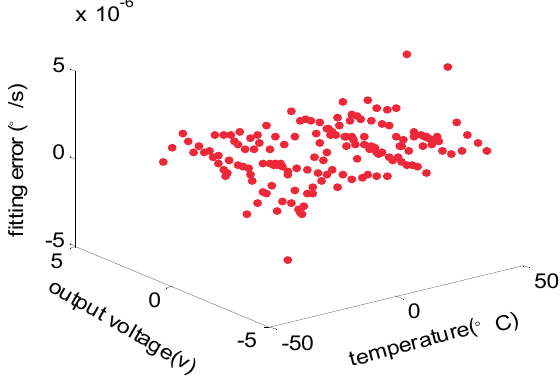
Figure 10. The fitting error of RBF neural network